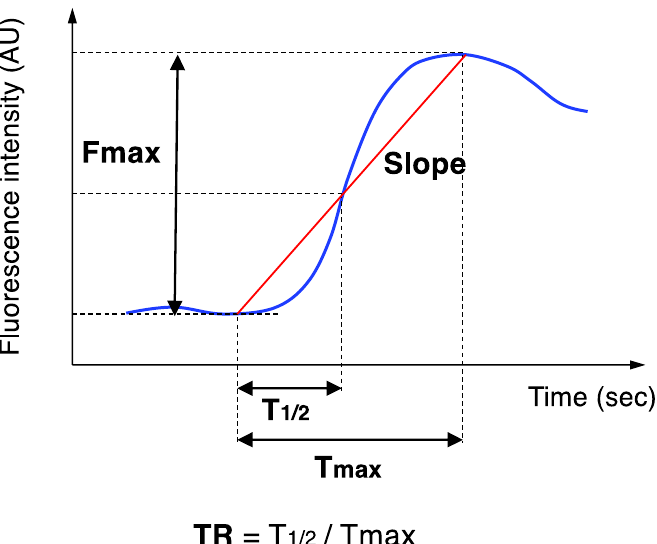
Figure 3. Time curve of ICG fluorescence intensity. Fmax, Tmax, T 1/2 , Slope, and TR were calculated.